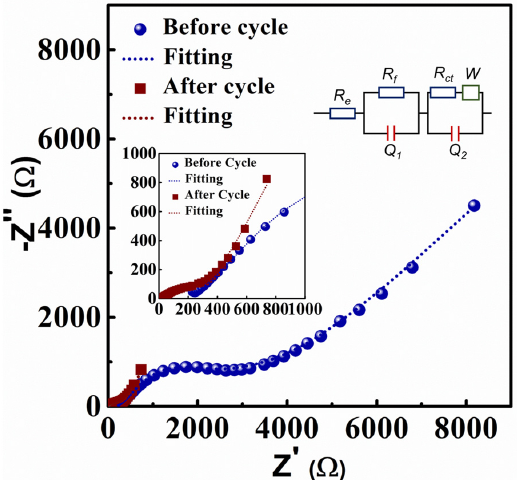
Figure 5. Nyquist plots of free-standing rGO/CNT paper in one Na–ion cell before and after cycle test. The insets show the semicircles in high frequency region and the equivalent circuit diagram used for fitting the Nyquist plots.